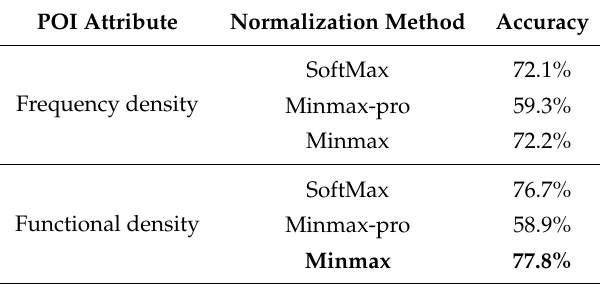
Table 5. The accuracy of different normalization method.